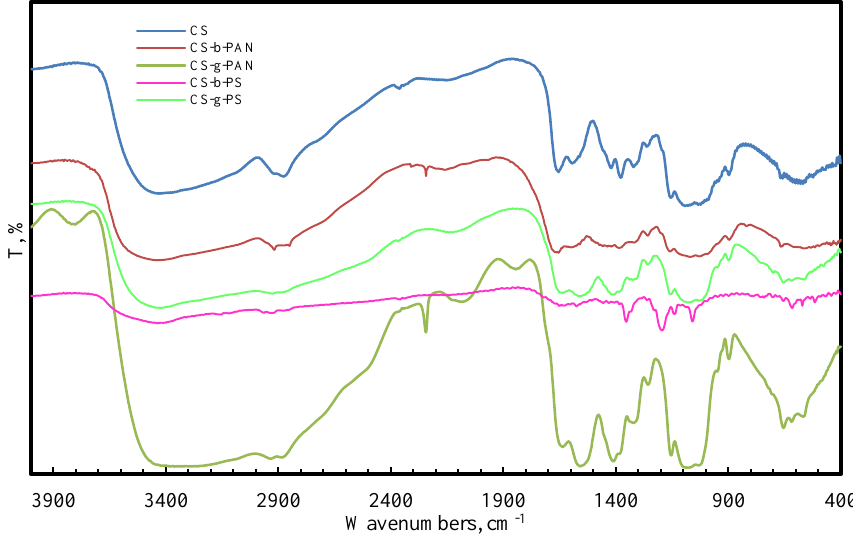
Figure 1. FTIR spectra of pure CS, CS-PAN copolymers, and CS-PS copolymers.